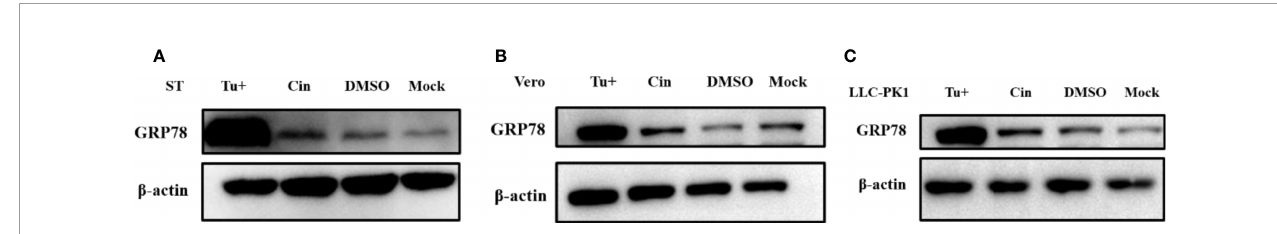
FIGURE 5 | Expression of ER stress marker protein GRP78 in cinchonine-treated cells. (A – C) Vero CCL81 cells, ST cells and LLC-PK1 cells were treated with 100 m M cinchonine for 24 h respectively, and the expression of GRP78 protein was examined by Western Blot analysis.